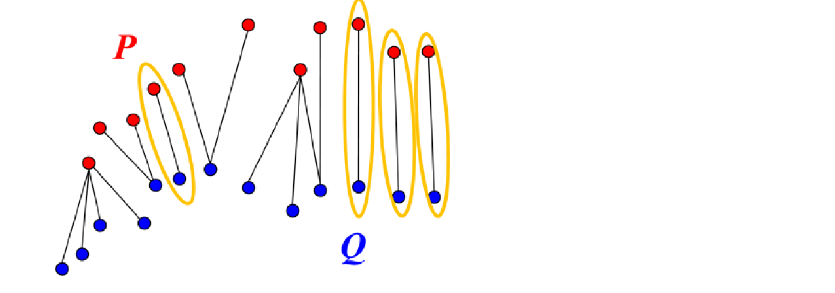
Figure 4. Mutual nearest neighbor correspondences for GPA-ICP are circled. The version of the algorithm in this work determines the mutual nearest neighbors between the two point sets and runs the ICP algorithm based on these